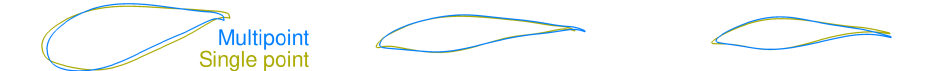
Figure 18. Comparison of airfoil profiles obtained from single-point and multipoint optimizations. The profiles are taken from 35, 64, and 84m spanwise positions.